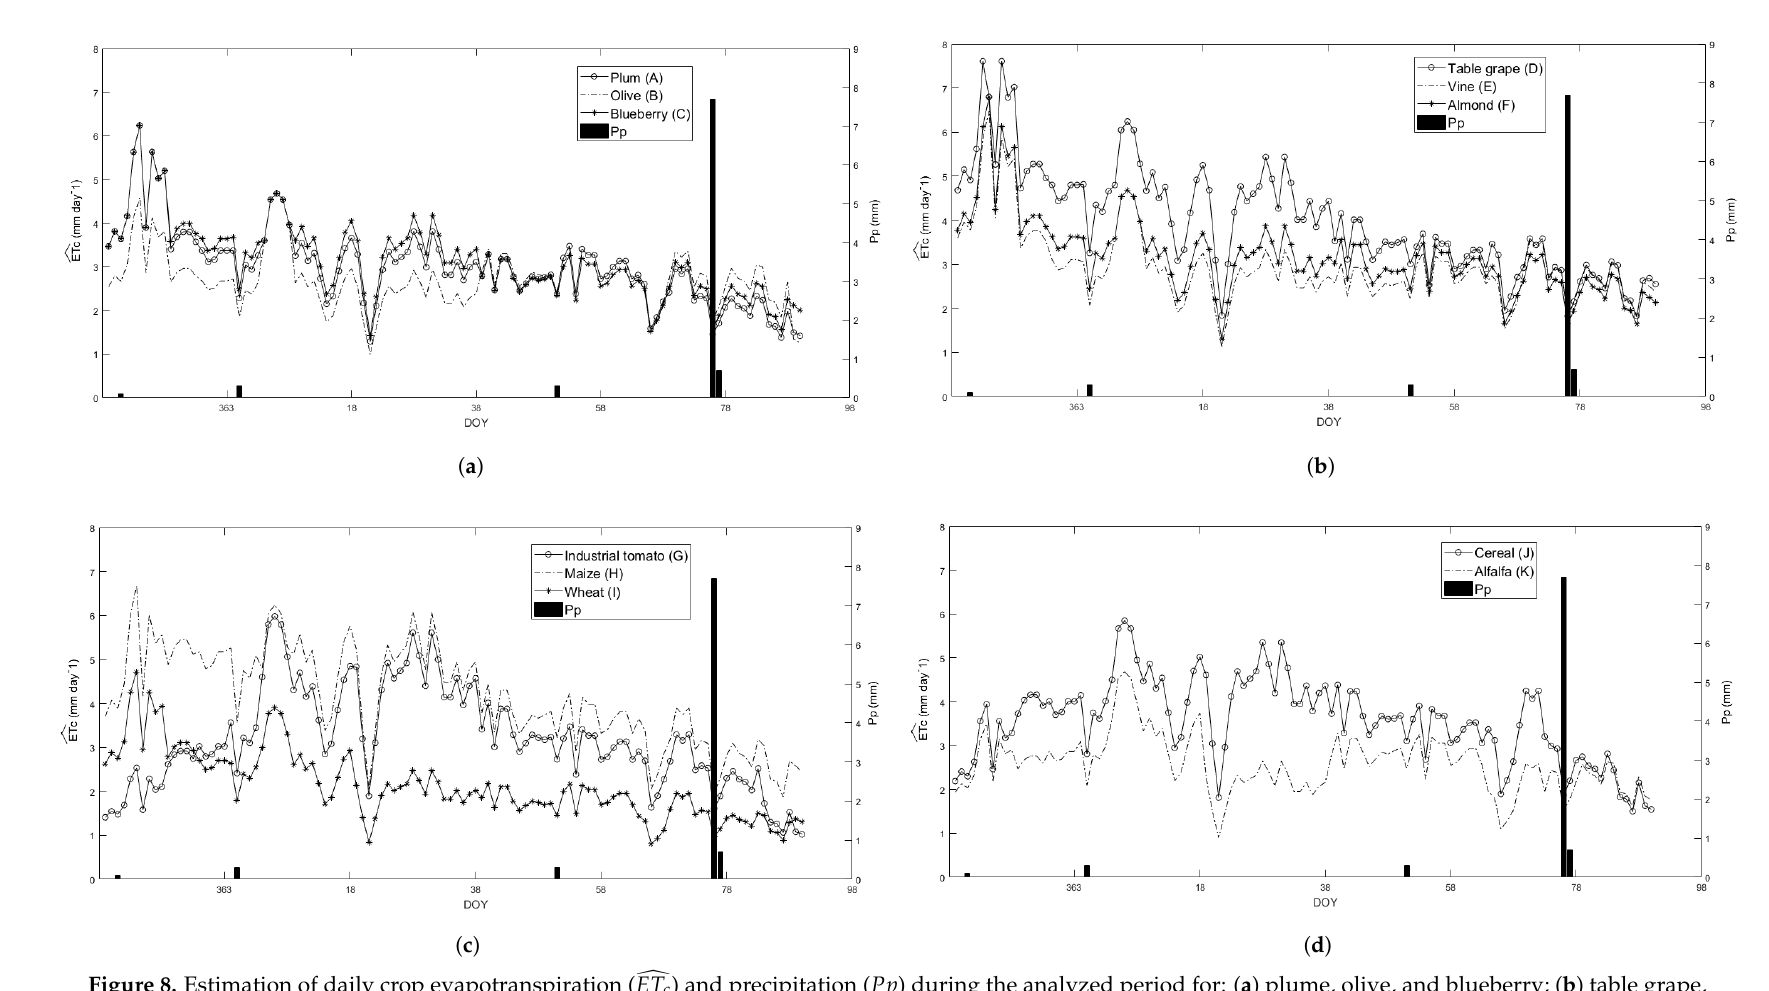
Figure 8. Estimation of daily crop evapotranspiration ( (cid:100) ET c ) and precipitation ( Pp ) during the analyzed period for: ( a ) plume, olive, and blueberry; ( b ) table grape, vine, and almond; ( c ) industrial tomato, maize, and wheat; ( d ) cereal and alfalfa; using the described